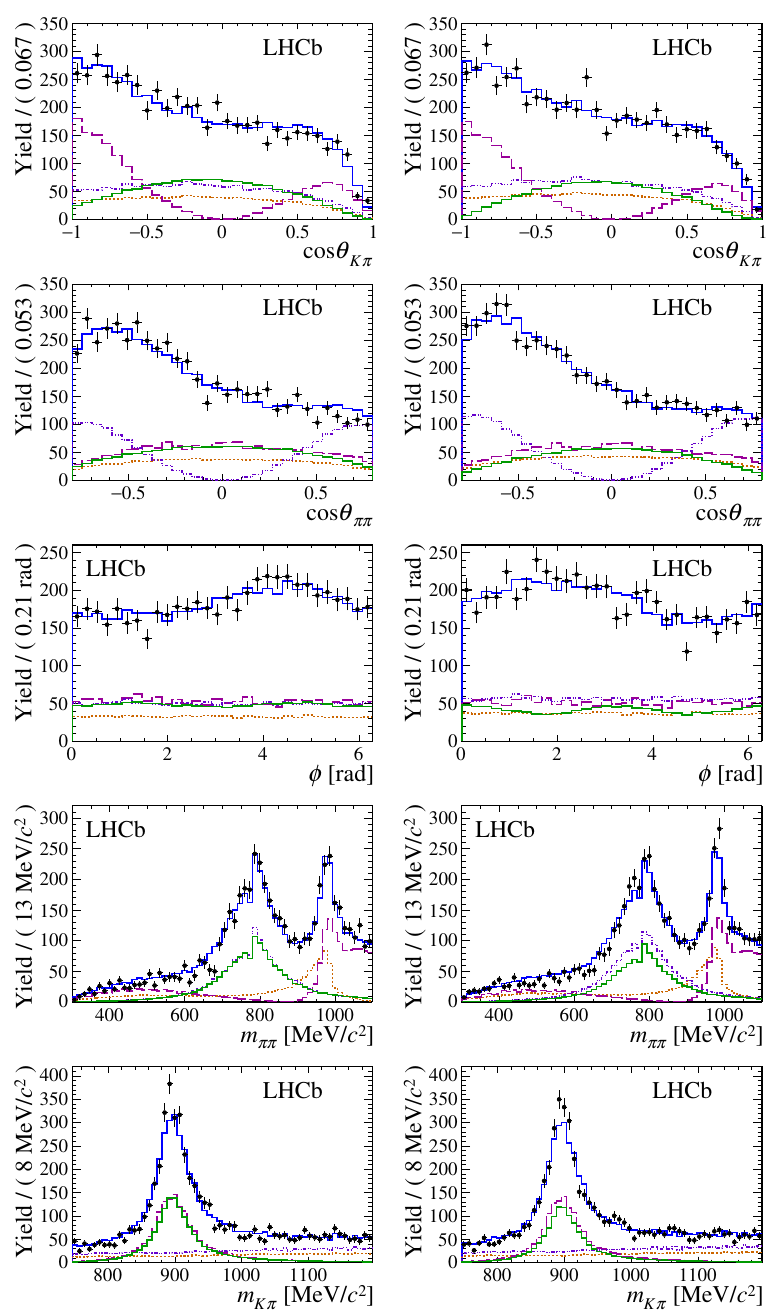
Figure 4. Projections of the amplitude (cid:12)t to the (left) B 0 and (right) B 0 data samples. The four trigger and data-taking year categories are aggregated in the (cid:12)gures. Data are shown by black points with uncertainties and the overall (cid:12)t is represented by the solid blue line. The contributions of the partial waves sharing the same angular dependence are shown as ( V V ) solid green, ( V S ) dash-dotted violet, ( SV ) dashed dark magenta and ( SS ) dotted orange lines. Direct CP -violating e(cid:11)ects are most visible in the projections of the V V component over cos (cid:18) K(cid:25) and cos (cid:18) (cid:25)(cid:25) and in the di(cid:11)erent oscillation frequency in (cid:30)